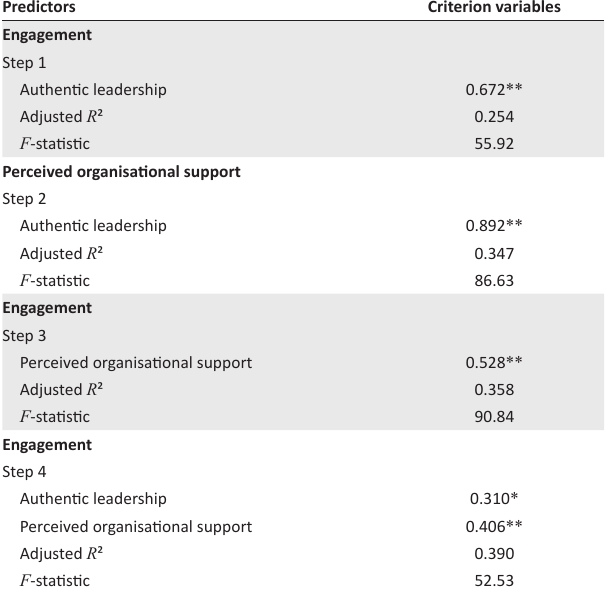
TABLE 4: Results of the hierarchical regression analysis ( n = 162). Predictors